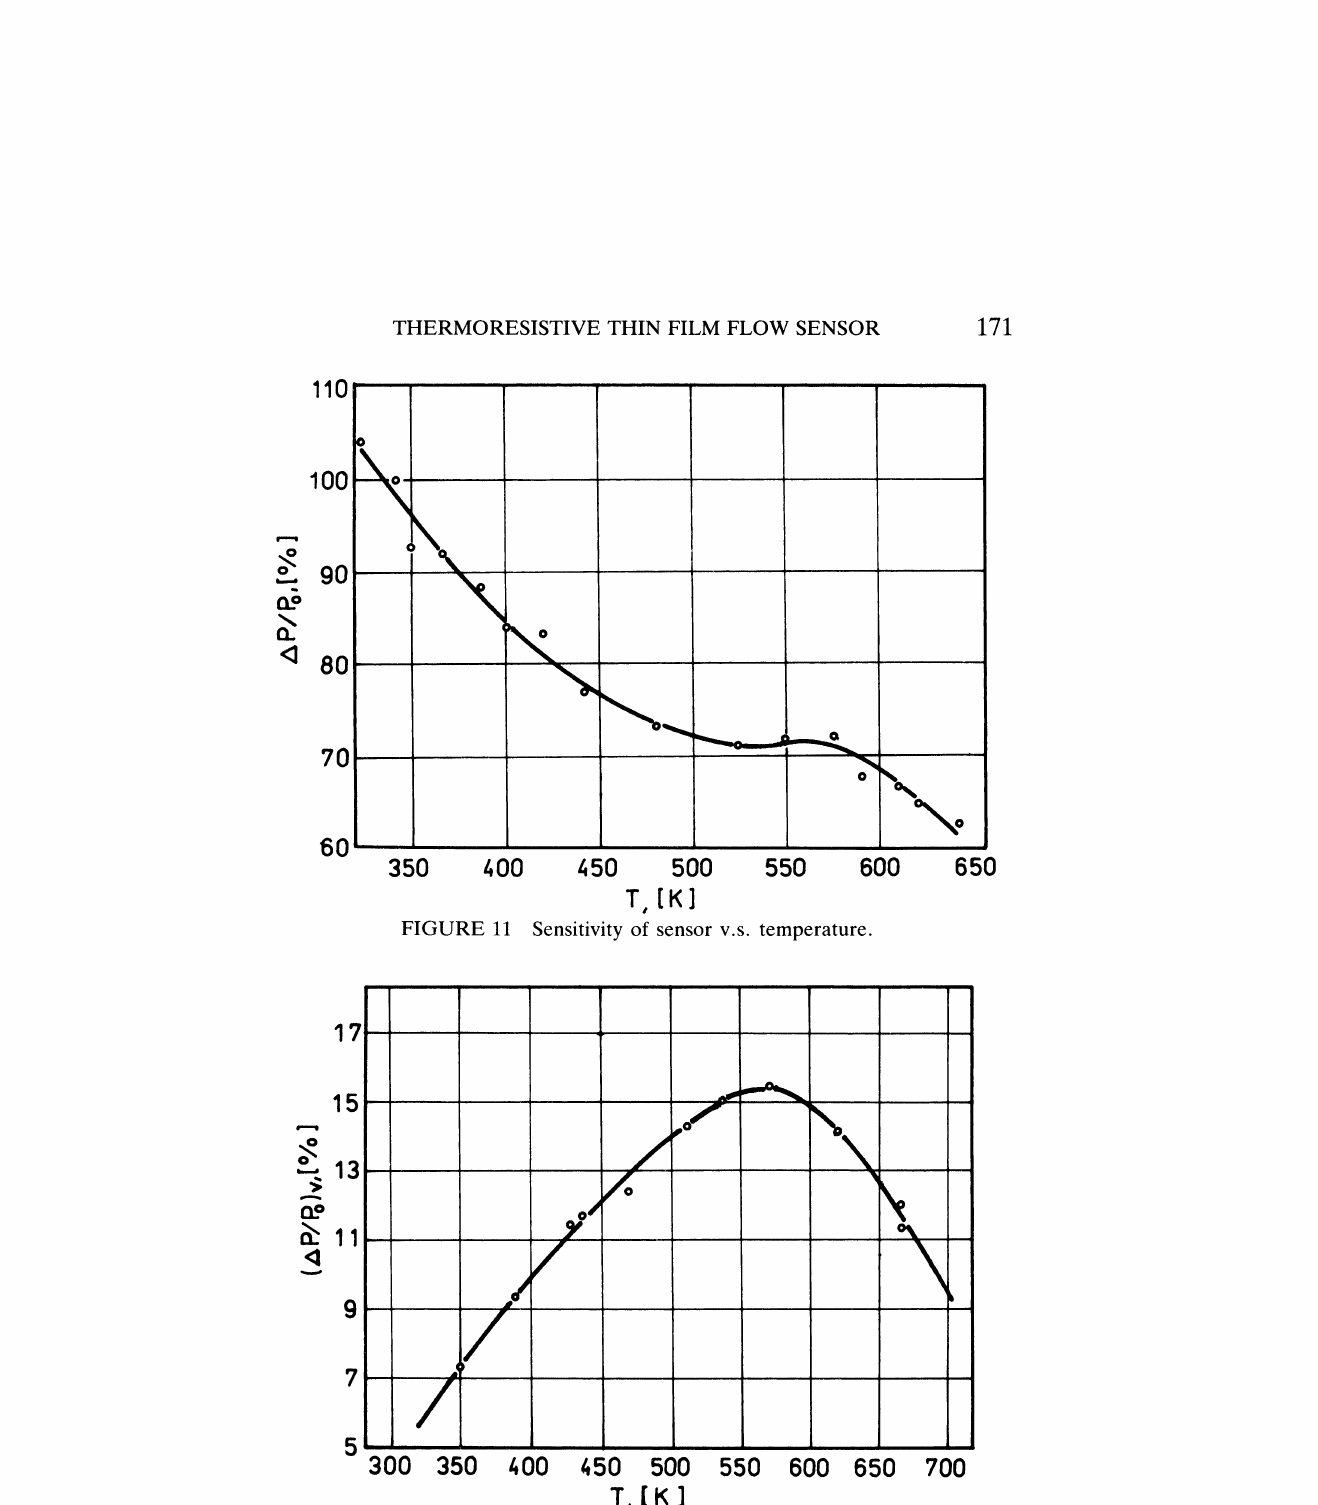
FIGURE 12 Changes in sensitivity of the sensor for a constant voltage supply as a function of